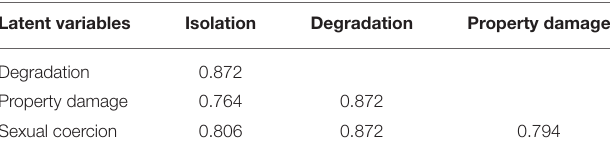
TABLE 8 | Discriminant validity (HTMT